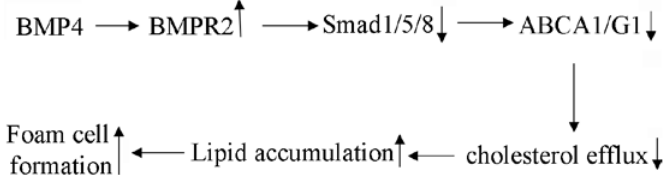
Figure 6. A schematic model presenting the pathway of BMP4 to affect foam cell